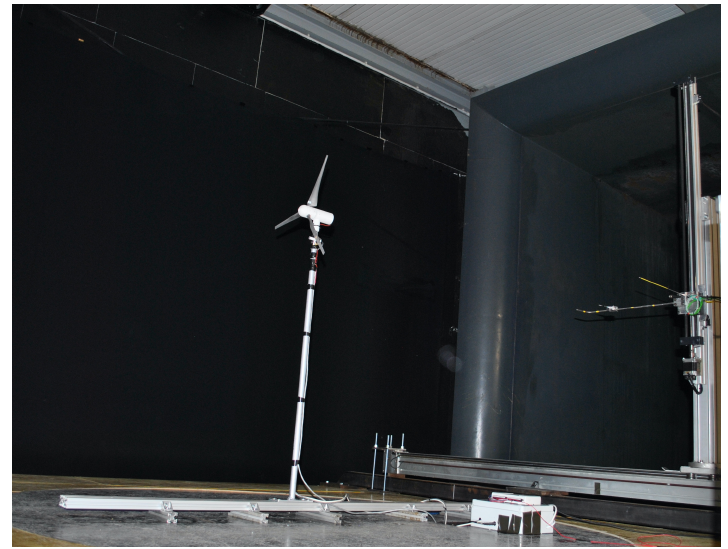
Figure 2. Photo showing the test